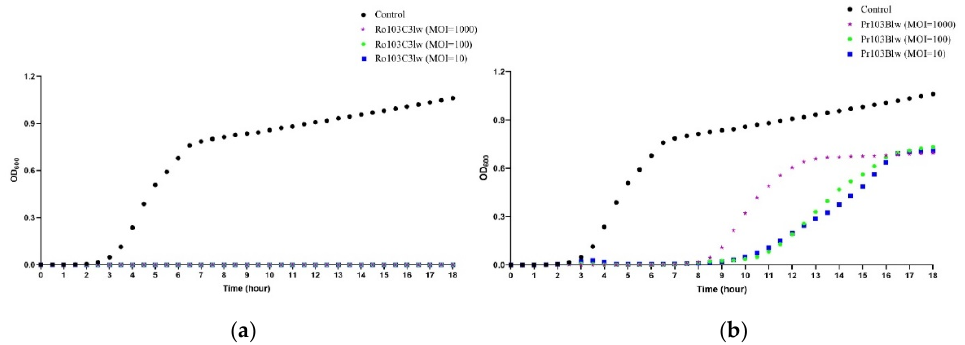
Figure 3. Bacterial challenge assay of the phage Ro103C3lw ( a ) and Pr103Blw ( b ) against E. coli O103:H2 cocktail (RM13322 and RM10744) conducted in a 96-well plate. The OD 600 was measured by spectrophotometer every 0.5 h for the period of 18 h incubation at 37 °C. The control (black circles) contains only bacterial culture. The multiplicity of infection (MOI) of 10 (blue squares) contains bacterial culture treated with 10-fold more concentration of the phage Ro103C3lw or Pr103Blw; MOI of 100 (green circles) contains bacterial culture treated with 100-fold more concentration of the phages; MOI of 1000 (purple stars) contains bacterial culture treated with 1000-fold more concentration of the phages.